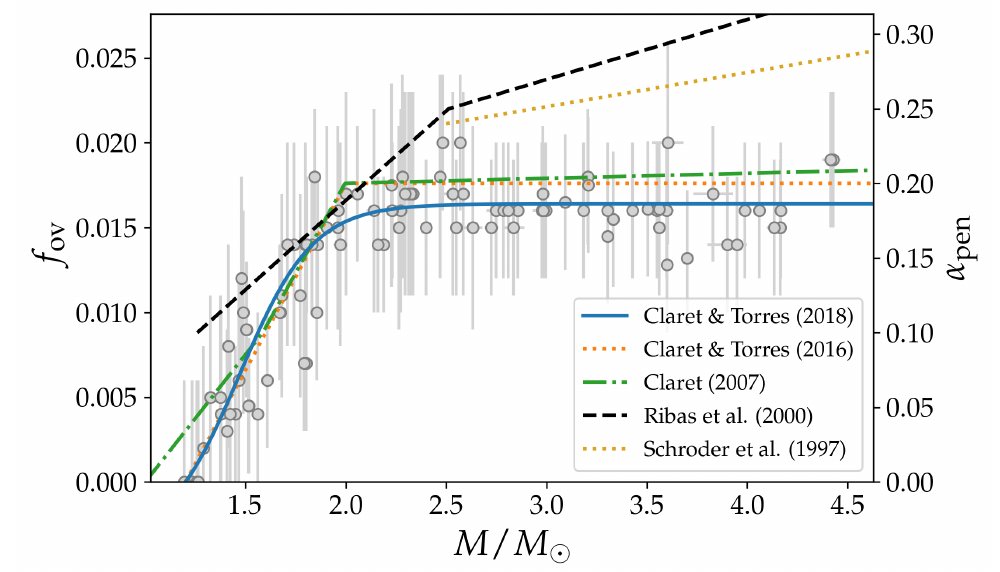
Figure 11. Inferred mass versus CBM obtained for a sample of 50 DDLEBs (gray points with errors) [262] compared to different empirical relations available in the literature obtained from modeling different samples of DDLEBs. Conversion factors of α pen / f ov = 11.36 [76] and α pen / α ov = 1 were assumed for the inclusion of the individual curves in the figure. The plotted range is limited to the mass range of the 50 = 0.006 were assumed for main-sequence stars, while σ = 0.004 were used for DDLEBs. Errors of σ f f ov ov giants [262]. Figure made by the authors using data from Claret and Torres [262], Claret and Torres [20], Claret and Torres [76], Claret and Torres [258], Claret [261], Ribas et al. [260], and Schroder et al.